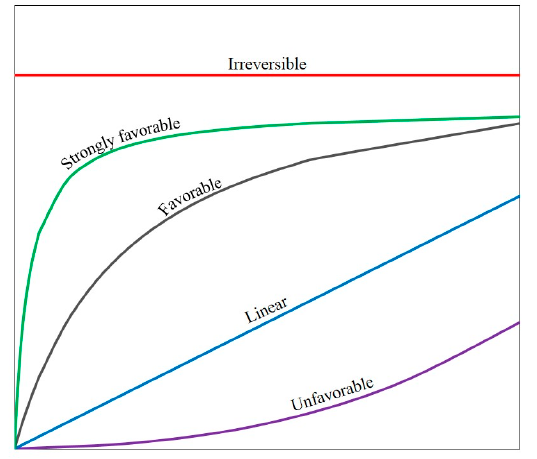
Figure 10. Nature of the adsorption isotherms [35].